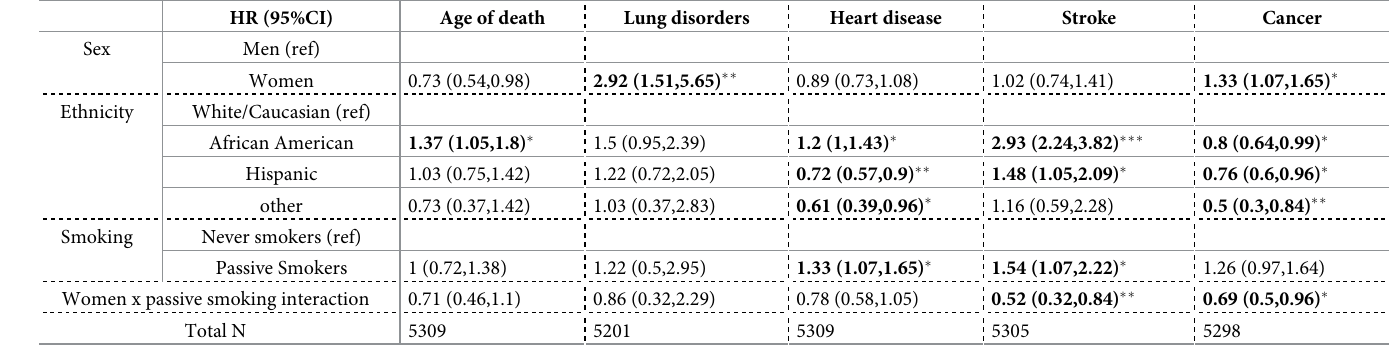
Table 2. Hazard ratios of age of death, and age of onset of lung disorders, heart disease, stroke and cancer according to passive smoke and the interaction with